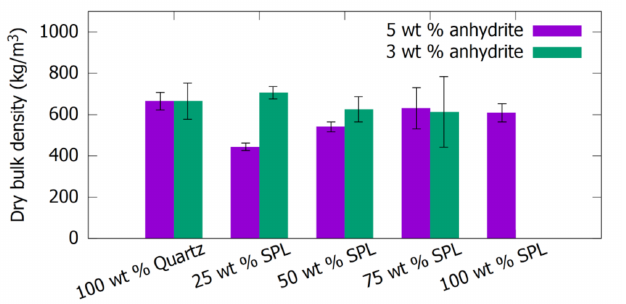
Figure 11. Density of the AAC blocks using several replacement levels of quartz for SPL aluminosili- cates after drying at 40 ◦